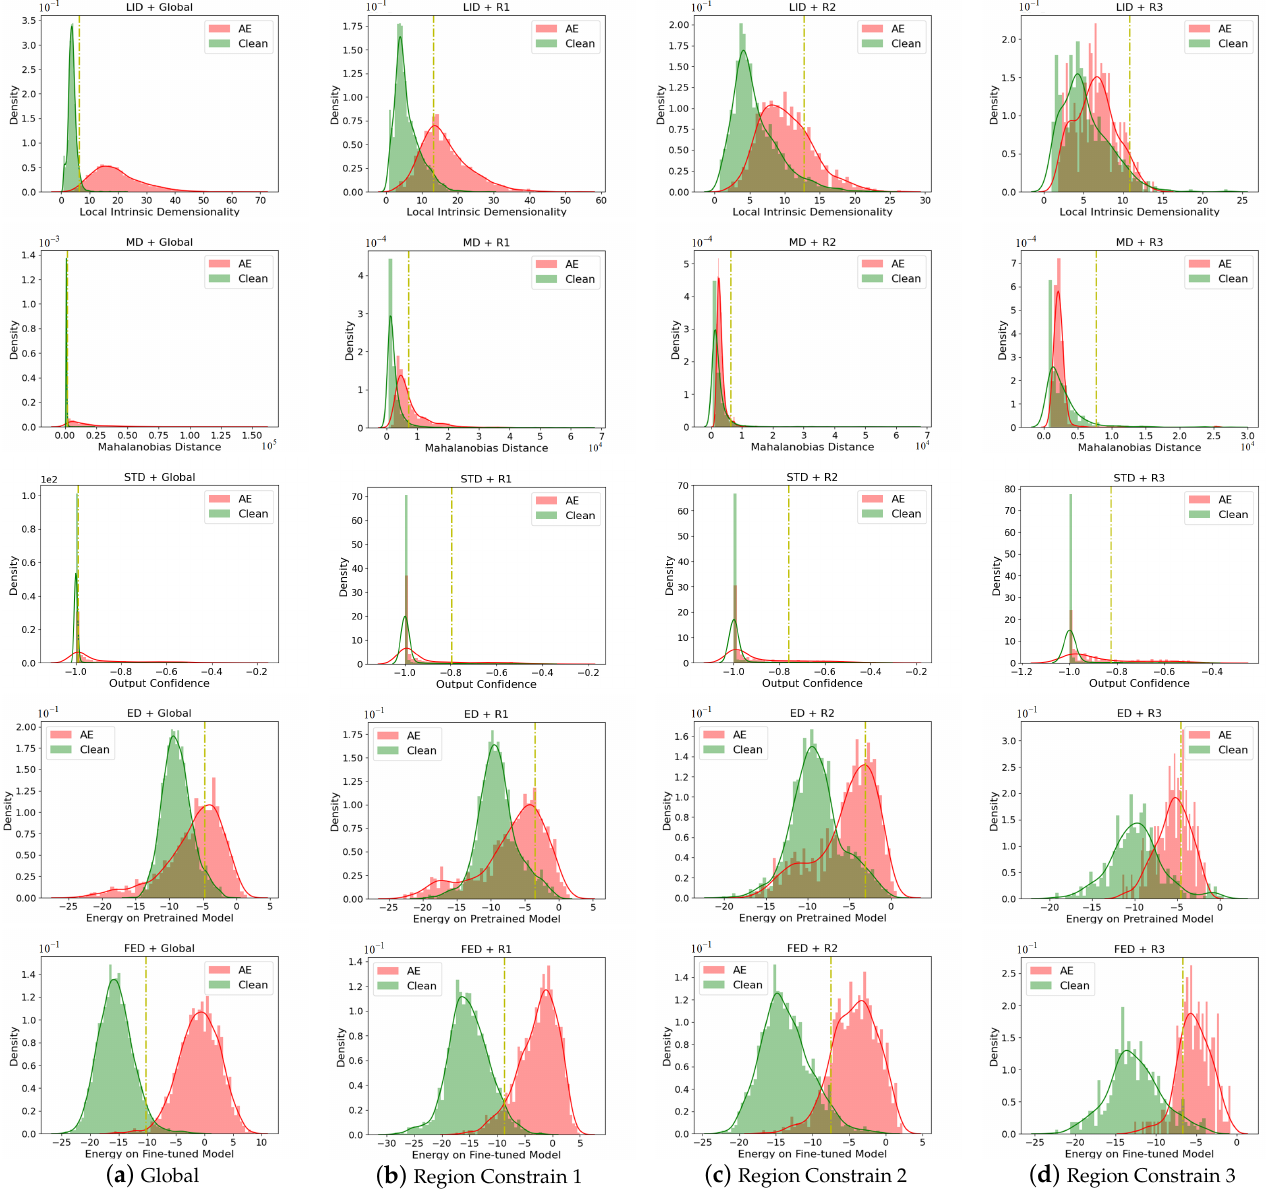
Figure 7. Visualization of energy distributions of clean samples and FGSM AEs on DenseNet121. The columns represent the four methods of the LID, MD, ED, and FED, and the rows represent four different regional constraints. The dashed yellow line is positioned at a 95% true positive rate